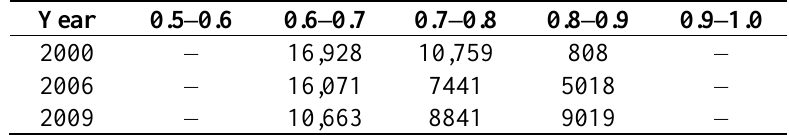
Table 7. Unit supply index of land ecological security in Guangzhou